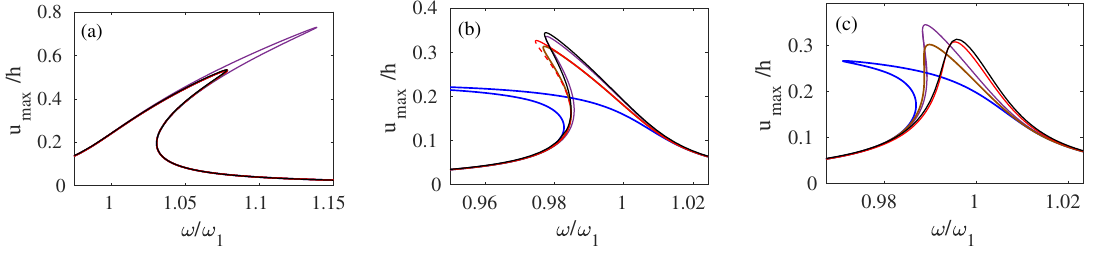
Figure 6. The frequency-response functions (FRFs) for the beam ( a ), shallow arch ( b ), and non-shallow arch ( c ). Red: DNF, blue: SMD, brown: MD, purple: ICE method, black: reference